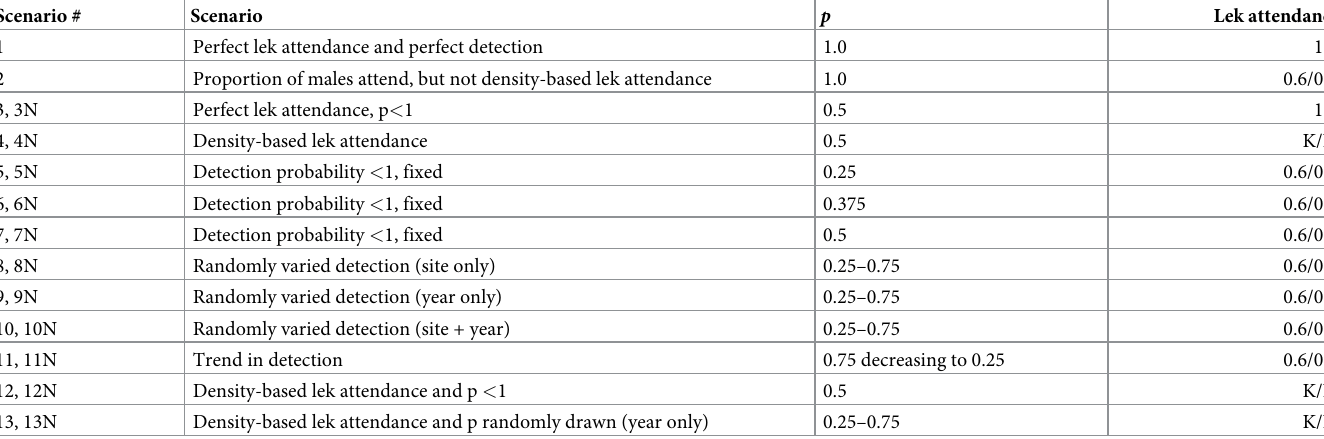
Table 2. Scenarios run in individual-based models for lesser